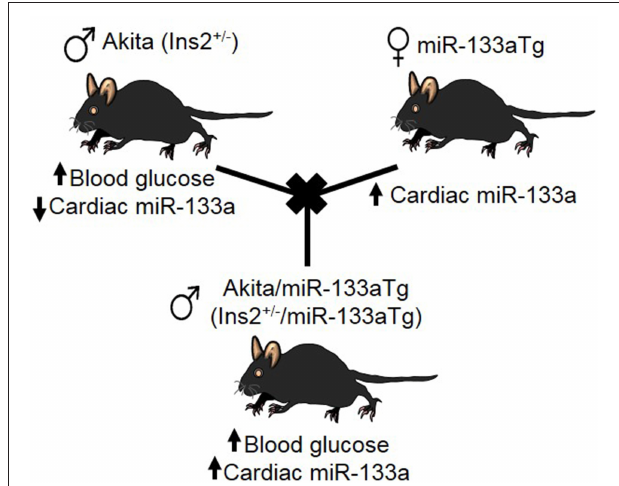
FIGURE 1 | Creation of Akita/miR-133aTg mice. Schematic presentation of crossbreeding of Akita and miR-133aTg mice to create the novel strain of Akita/miR-133aTg